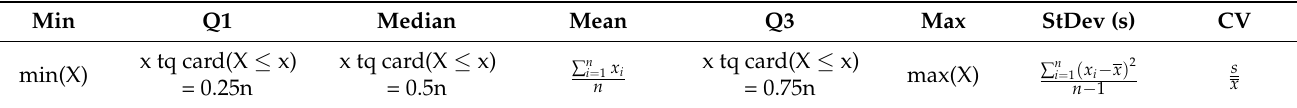
Table 2. Extended 5-Number Summary table.